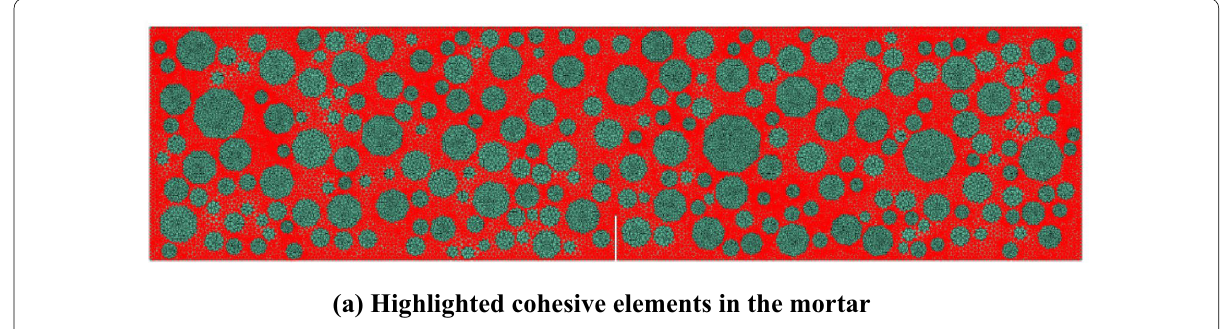
(a) Highlighted cohesive elements in the mortar